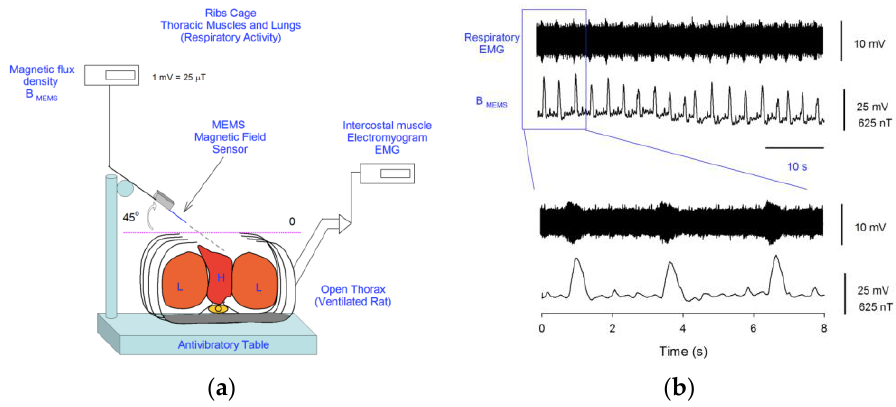
Figure 25. ( a ) Diagram of an experimental set up of a MEMS magnetic field sensor for monitoring the respiratory and cardiac activity of a rat; ( b ) Electromyogram of the thoracic muscles and magnetogram of the thoracic cavity during the respiratory activity of a rat [38]. Reprinted with permission from [38]. Copyright© 2013, Ivyspring International Publisher.